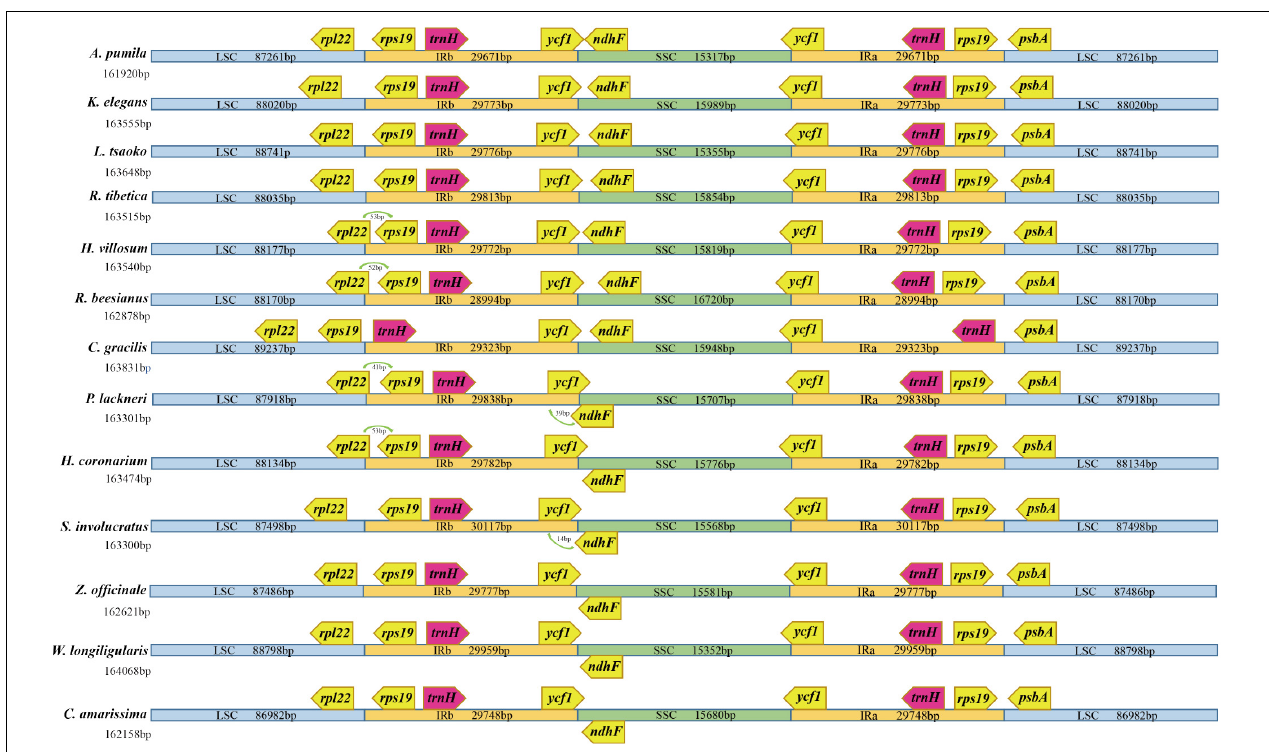
FIGURE 1 | Comparison of chloroplast genome structure in Zingiberaceae. IR (inverted repeat), LSC (large single copy) and SSC (small single copy) regions and border genes are indicated.